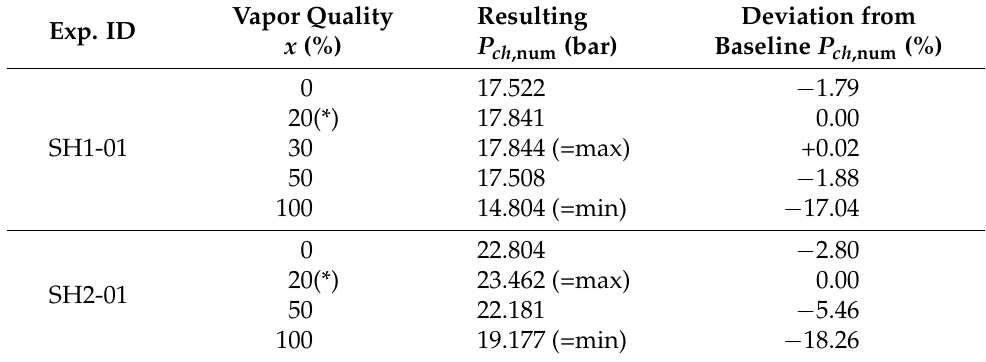
Table 10. Effect on P ch ,num when varying the oxidizer inlet vapor quality x .